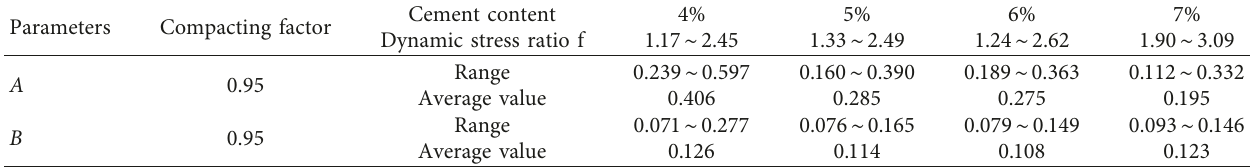
Table 1: Accumulative plastic strain model parameters of the improved CWG.